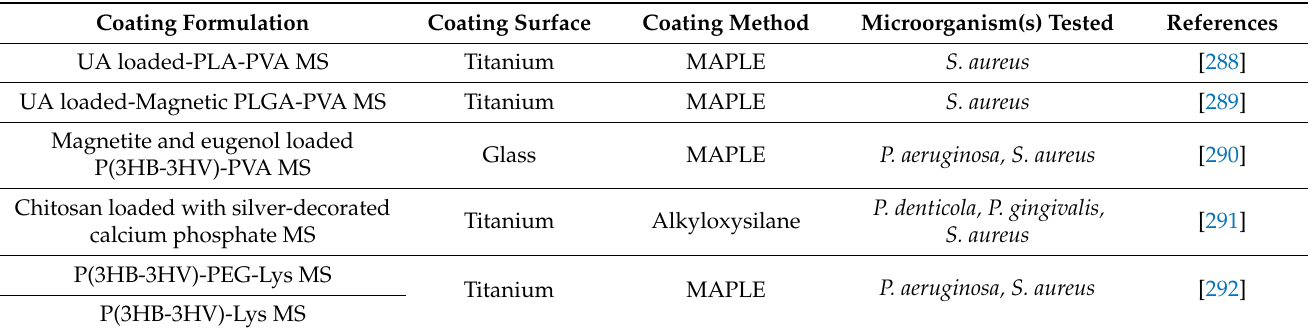
Table 5. Summary of coatings used with antibiofilm